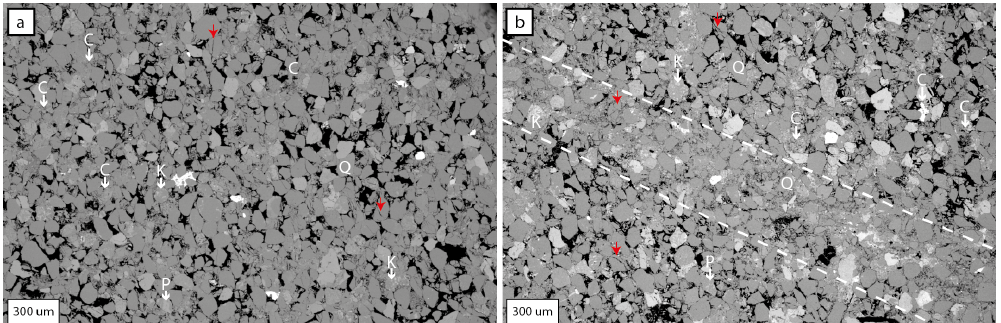
Figure 12. BSE images of host rock surrounding D3 SECBs and a D3 SECB characterised by minimal shear offset. Macroscopically, these bands have a periodic spacing and are distal to fault planes. (a) BSE image of host rock located within 5cm of an SECB. Within the host rock, clusters of clay-sized particles and fragmented host-rock grains are present. Pore space is visible between grains. Microfractures are present in host-rock grains (examples are indicated by red arrows). (b) SEM image of a D3 SECB (borders marked by white dashed lines) hosted within less deformed host rock. The band has diffuse edges and is characterised by a reduction in porosity and an increase in clay content compared with the surrounding host rock. Towards the edge of the band, porosity is better preserved, indicating the diffuse nature of the band edges. Many host-rock grains within the band are preserved, with little to no reduction in grain size. These grains are surrounded by fragments of host-rock grains that are generally clay-sized. Q denotes quartz, C denotes zones of clay-sized particles, K denotes potassium feldspar, and P denotes